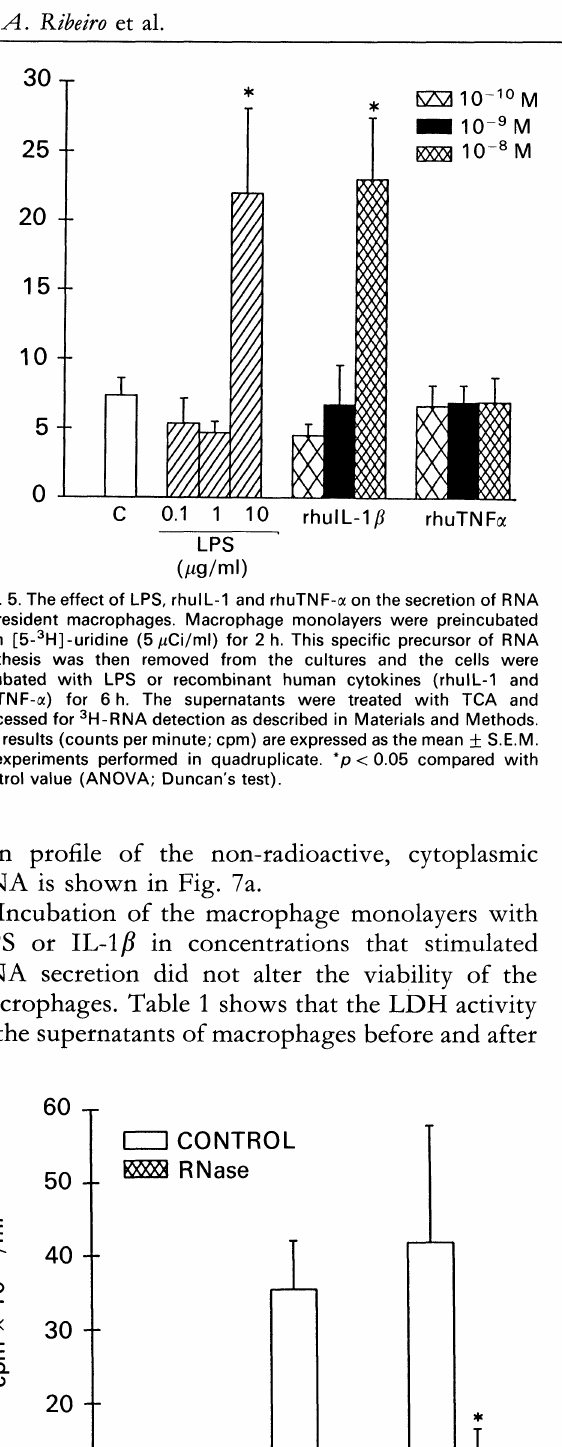
Table 1. Detection of LDH activity in the supernatants of macro- phage monolayers treated with LPS, rhulL-1 and rhuTNF- ___ FIG. 6. The effect of RNase treatment of RNA secreted by macrophages Treatment stimulated with LPS and rhulL-1. Macrophage monolayers were preincubated with [5-3H]-uridine (5#Ci/ml) for 2 h. This specific precursor of RNA synthesis was then removed from the cultures and the cells were incubated with rhulL-1 (10 -8 M) or LPS (10 #g/ml) for 6 h. The supernatants were incubated with RNase TCA and processed for 3H-RNA detection as described in Materials and Methods. The results (counts per minute, cpm) are expressed as the mean S.E.M. of three experiments performed in duplicate. *p < 0.05 compared with respective Data are the means of two control. (ANOVA; Student’s test).